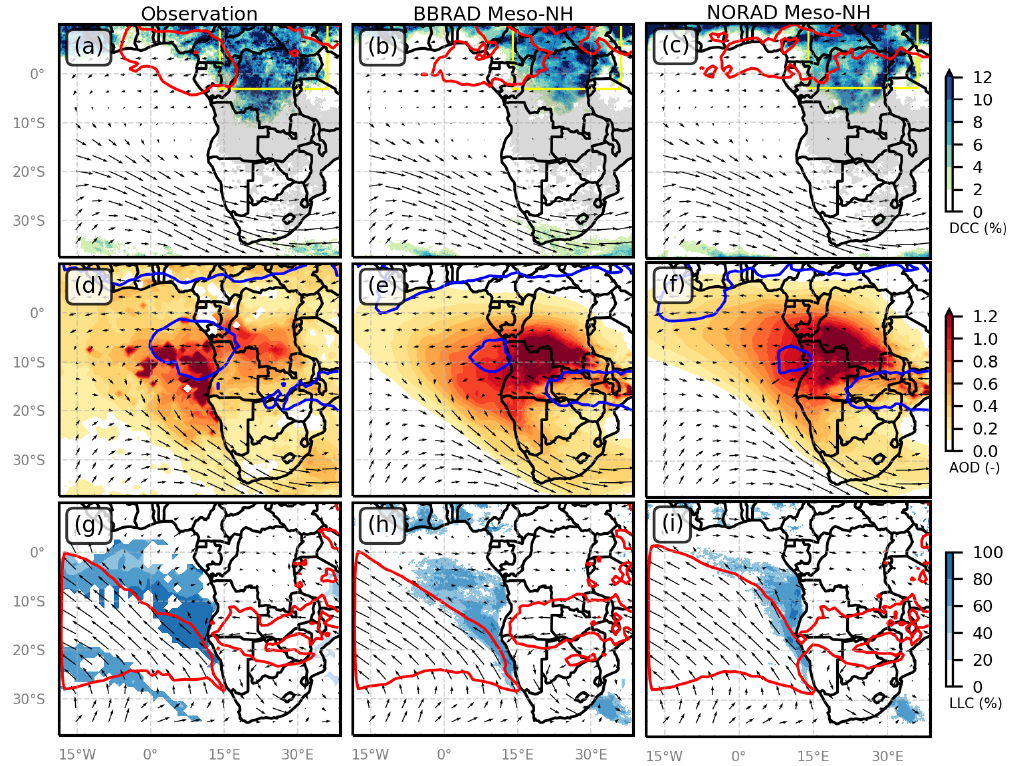
Figure 3. Top row: occurrence of deep convective clouds from (a) SEVIRI, (b) BBRAD and (c) NORAD. Fire sources are shaded in grey. Middle row: AOD from (d) MODIS, (e) BBRAD and (f) NORAD. Bottom row: occurrence of low-level clouds from (g) MODIS, (h) BBRAD and (i) NORAD. Arrows show the winds at (a–c) 12km, (d–f) 4km and (g–i) 1km a.g.l. from (a, d, g) ECMWF, (b, e, h) BBRAD and (c, f, i) NORAD. Contours show the zonal wind at (a–c) − 12, (d–f) − 8 and (g–i) − 4ms − 1 at 12, 4 and 1km, respectively. Fields are averaged between 8 and 16 September 2017, and BBRAD and NORAD fields are ensemble